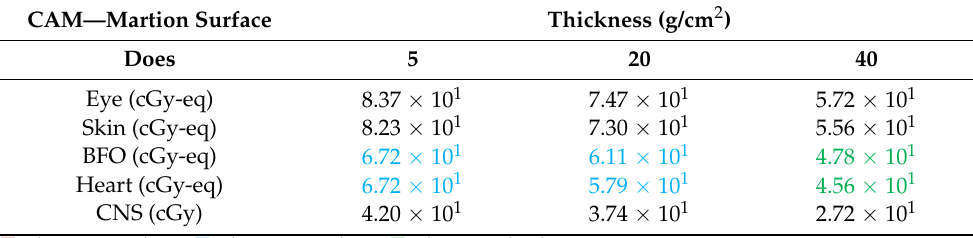
Table 4. Organ doses from 993/4 SPE for CAM on the surface of Mars behind various thicknesses of aluminum